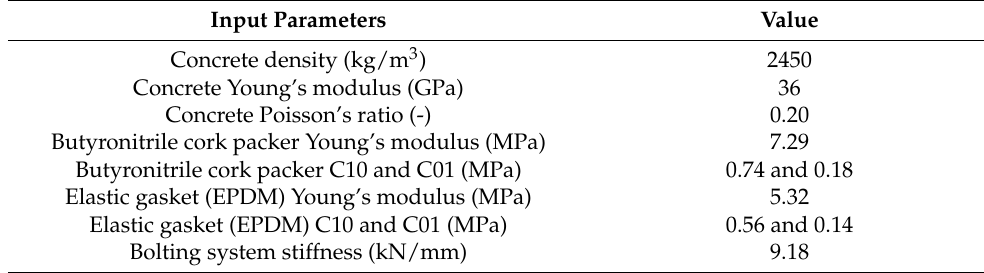
Table 3. Constitutive parameters for the finite element